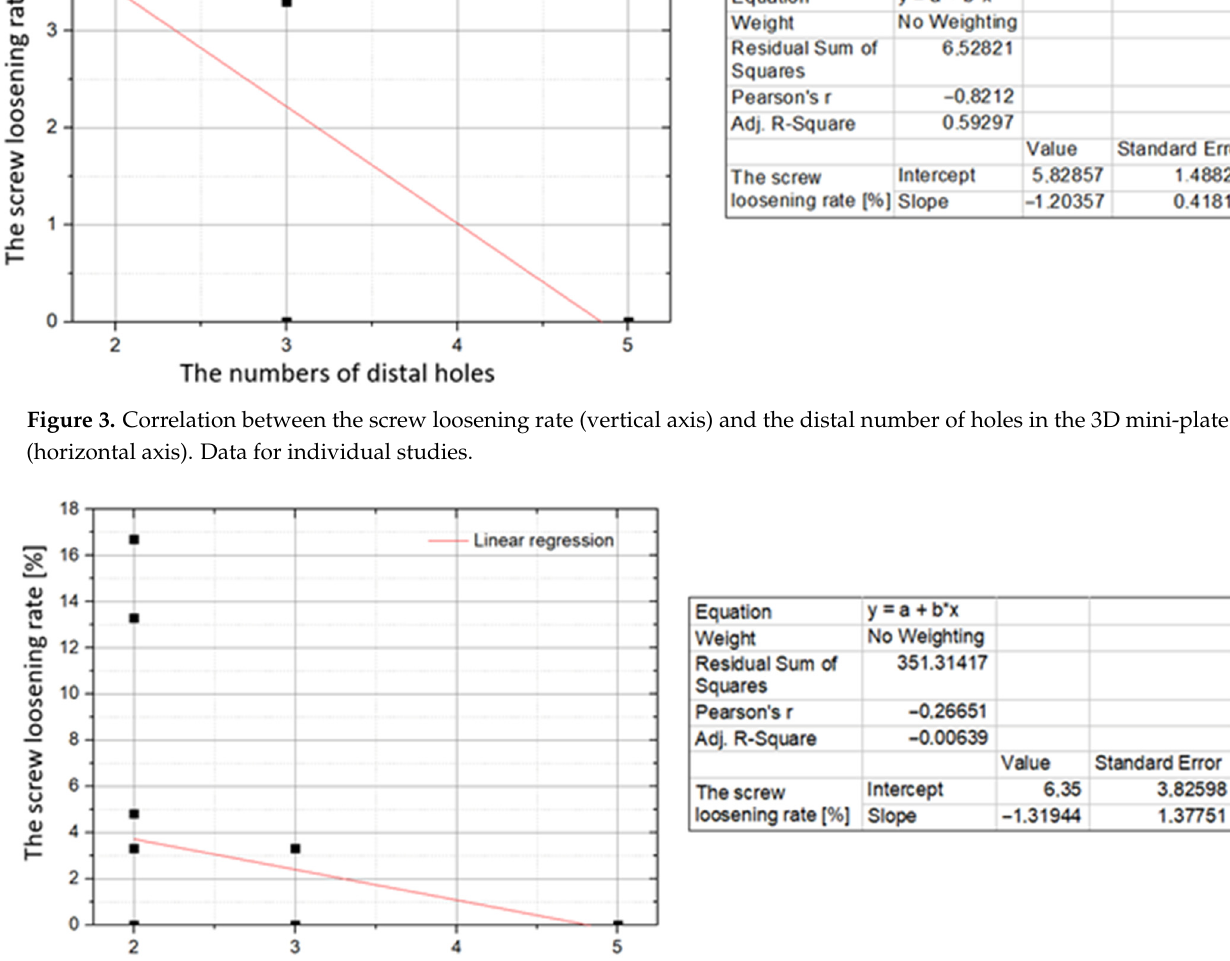
Figure 4. Correlation between the screw loosening rate (vertical axis) and the number of distal holes in the 3D mini-plate (horizontal axis). Data for individual shapes of 3D mini-plates.